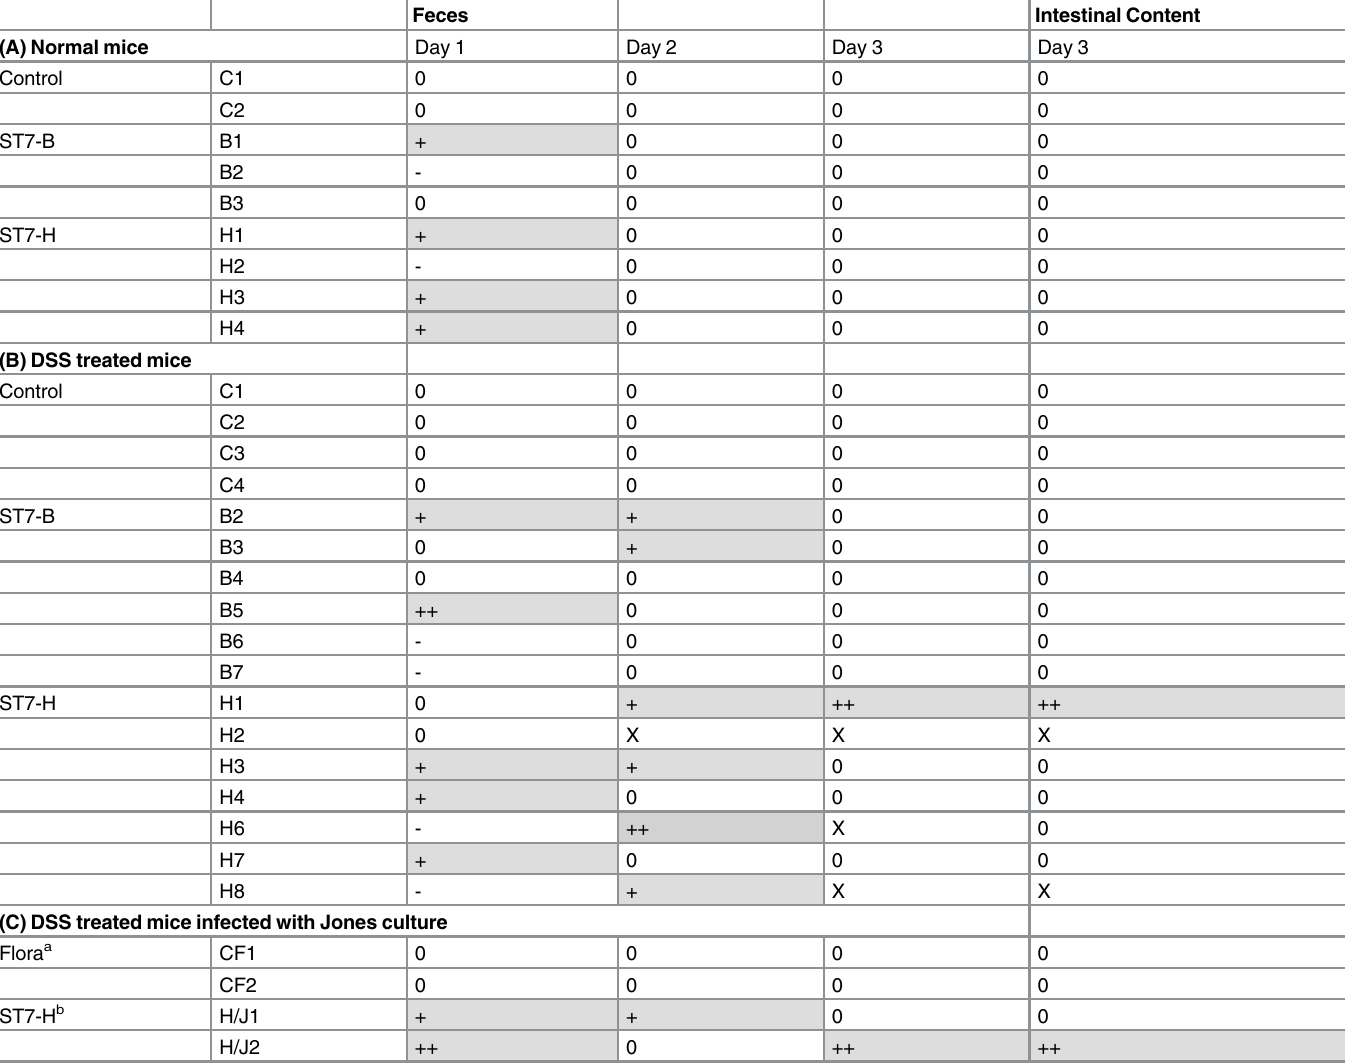
- indicates no sample collected, X indicates no sample collected as animal died, and 0 indicates Jones cultures remained negative after 10 day follow up. a Control mice were infected with bacterial fl ora recovered in Jones cultures to ascertain no pathological effect. b Mice infected with Jones cultures of 5x10 6 Blastocystis